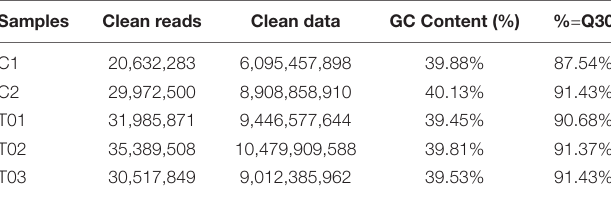
TABLE 1 | Statistics of the sequencing data.